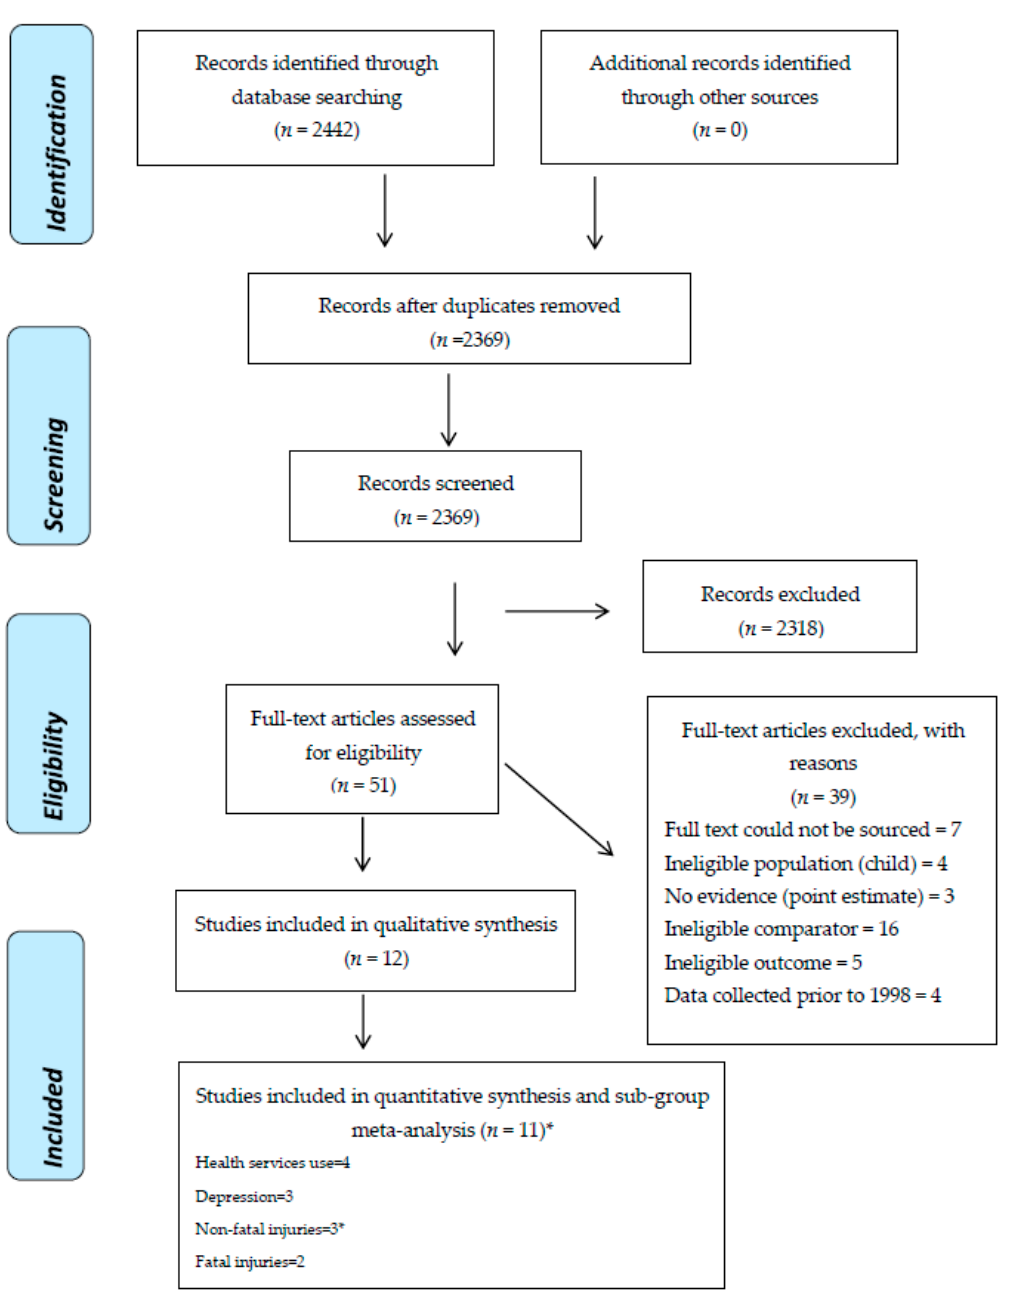
Figure 1. PRISMA diagram of study selection. * One paper included two outcomes.